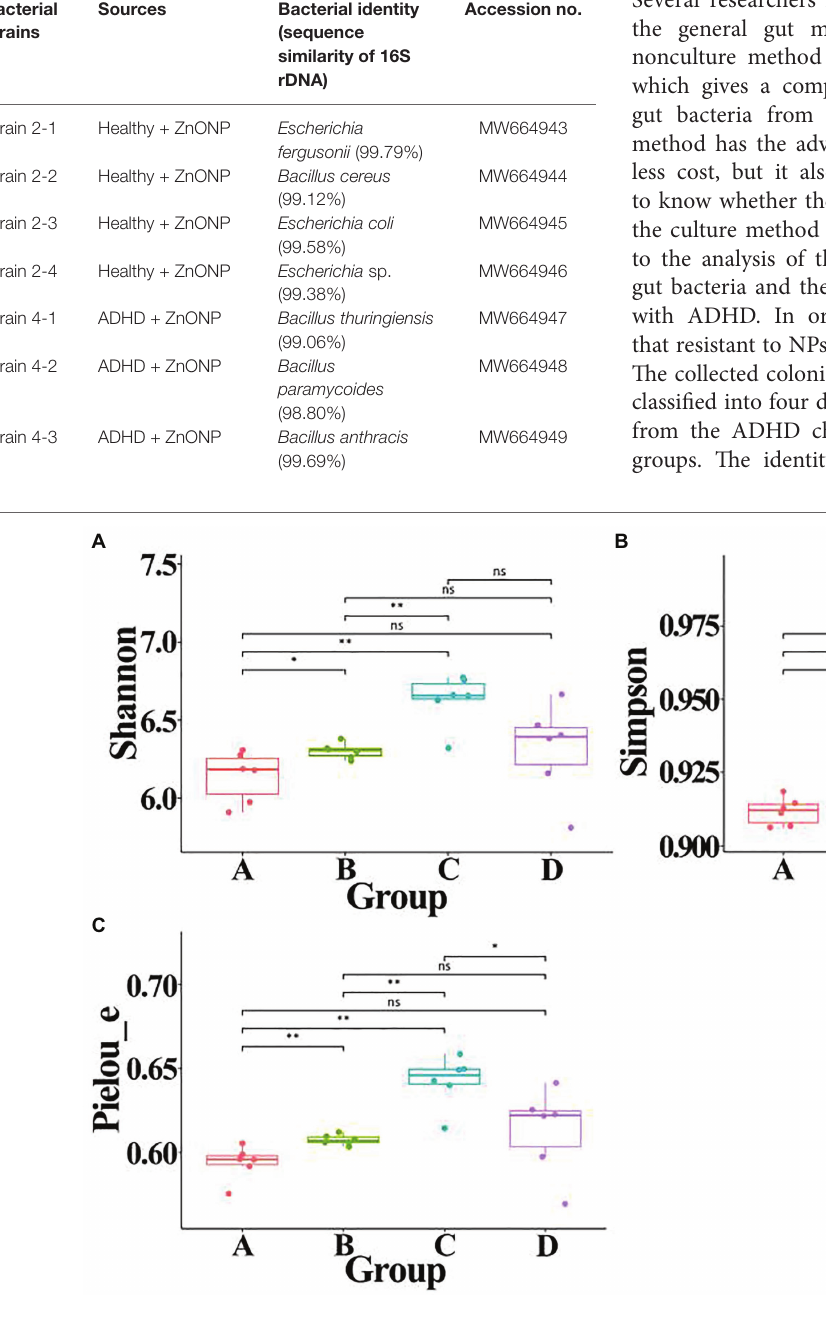
FIGURE 6 | Alpha diversity of gut bacteria from healthy and ADHD children in the presence or absence of ZnONP. (A) Shannon index; (B) Simpson index; and (C) Pielou_e index. A: Healthy; B: healthy + ZnONP; C: ADHD; and D: ADHD + ZnONP. Vertical bars represent standard errors of the mean ( n = 6). * p ≤ 0.05; ** p ≤ 0.01. ns, not